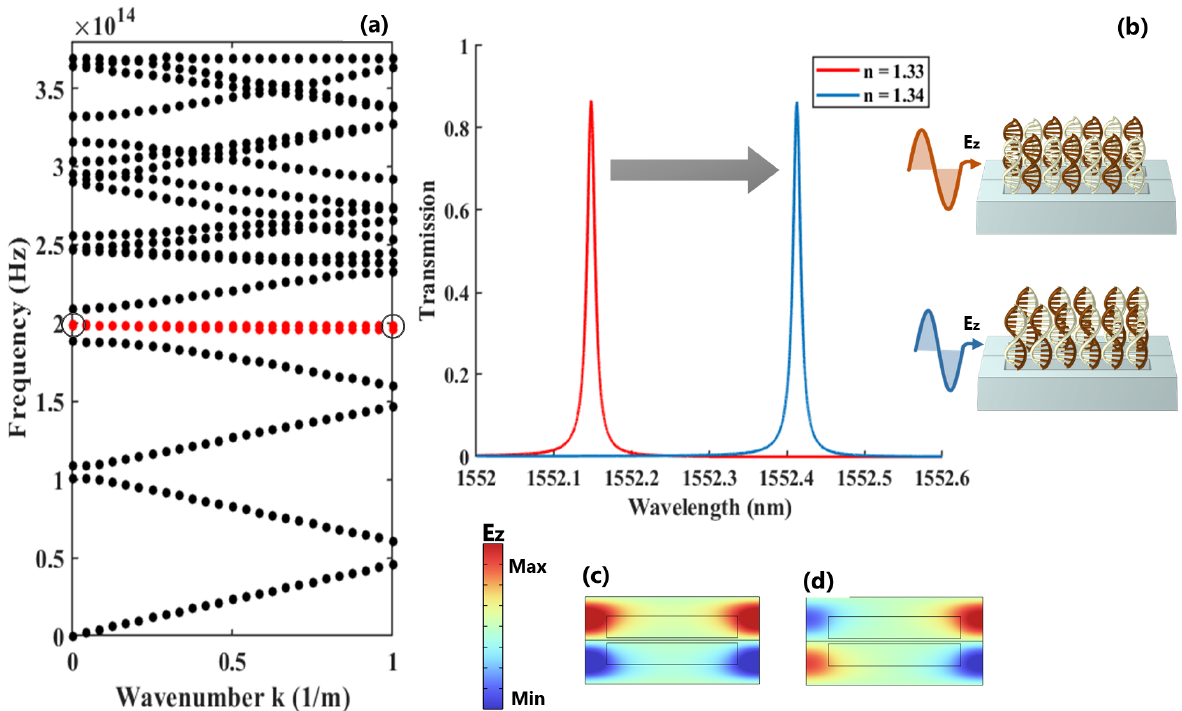
Figure 3. ( a ) The energy-momentum diagram of dimer PhC along the Γ X direction, indicating the allowed TE modes throughout this direction; ( b ) the spectral shift of the resonance when the refractive index of the sample changes from 1.33 to 1.34; ( c , d ) the representation of the electric field distribution at the resonance and anti-resonance points,